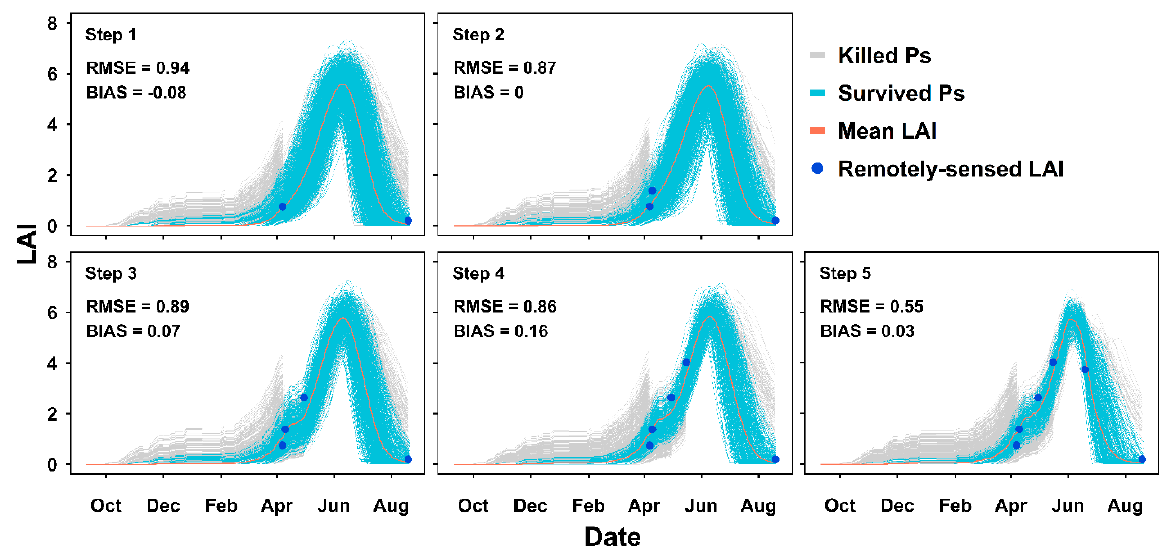
Figure A4. An independent run for data assimilation with 2500 number of particles using remote sensing data in five steps at EC6 in 2017. Cyan lines represent the surviving particles at each step and the gray ones shows the killed particles.